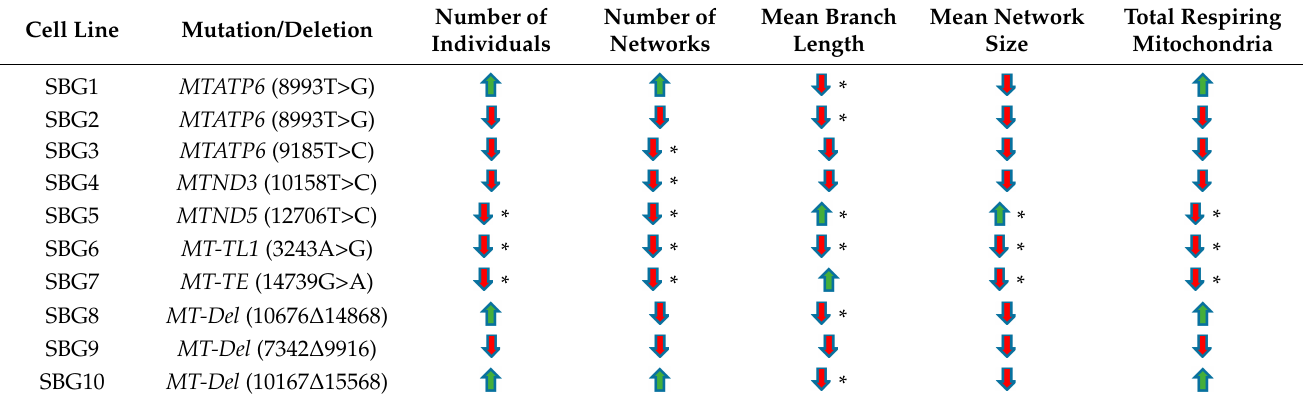
Figure 15. Mitochondrial morphology summary for fibroblast cell lines. Comparison of mitochondrial morphology of diseased and healthy fibroblast cell lines under basal conditions. Results suggest that diseased cell lines tend to have fewer respiring mitochondria with small branches and fragmented networks. In some cases, however, as seen in SBG5 and SBG7 fibroblasts, hyperfusion serves as a compensatory mechanism. * is used to signify data that is statistically significant between healthy and diseased